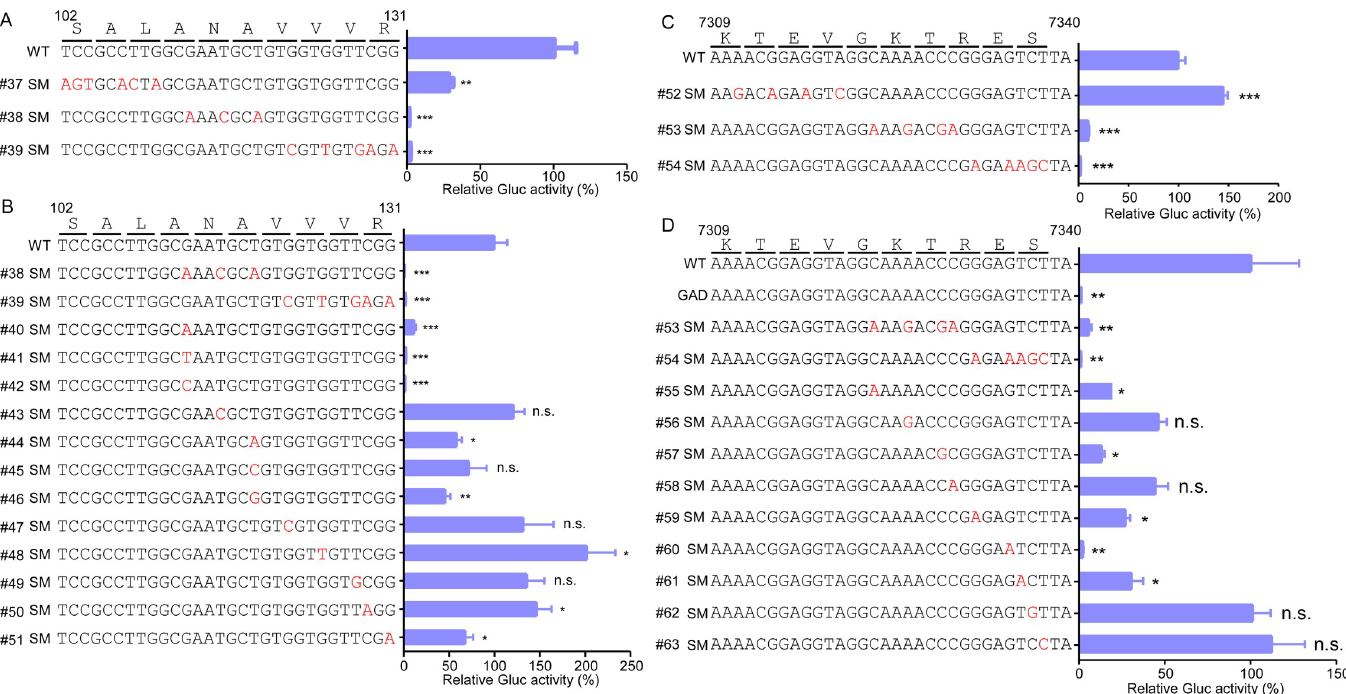
Fig 2. The synonymous mutations in the cis -acting RNA elements severely impair HEV replication. Synonymous mutations were introduced in the (A-B) ORF1 (102- 131nt) or (C-D) ORF2 (7309-7340nt) coding regions. rHEV-Gluc WT, synonymous mutants, or GAD mutant replicon RNA were transfected into HepG2C3A cells. Cell culture medium was collected two days after transfection and Gaussia luciferase activity quantified. The data are presented as the percentage of Gaussia luciferase activity relative to that of the WT rHEV-Gluc replicon. The numbering denotes the positions of the Kernow C1/p6 viral genome. Values are means plus SD (n = 4). � , P < 0.05; �� , P < 0.01; ��� , P < 0.001; n.s., not significantly different by one-way ANOVA.